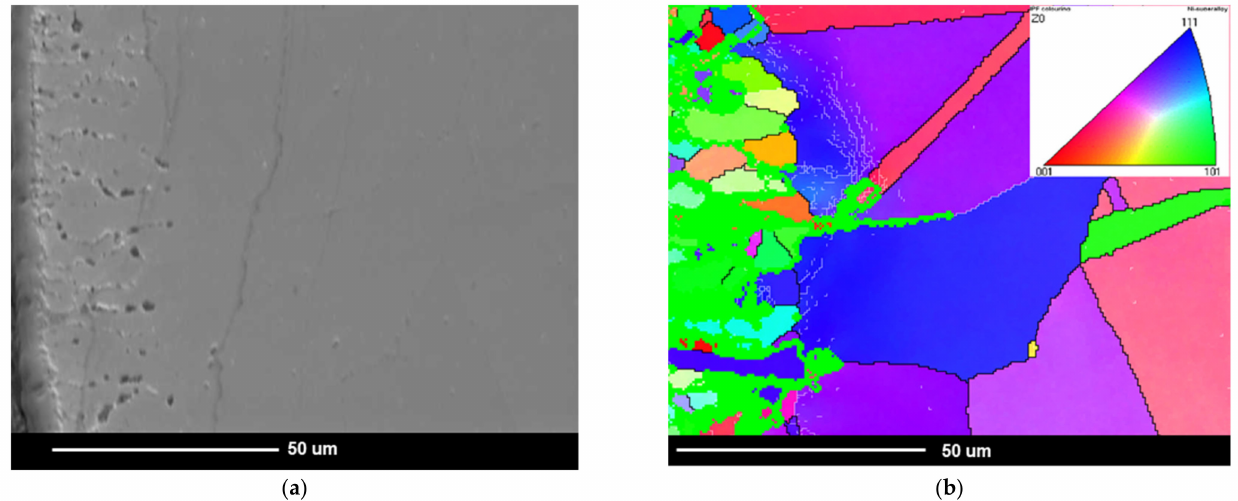
Figure 10. Investigation of grain orientation in Inconel 740H alloy after oxidation for 2000 h at 750 ◦ C in steam. EBSD: ( a ) microstructure of superalloy below the oxide layer, SEM image; ( b ) grain orientation map in the studied area in ( a ), IPF map. Thick lines represent HABs; thin lines represent LABs; color interpretation according to the stereographic triangle where red is <001> direction, green is <101> direction, and blue is <111>